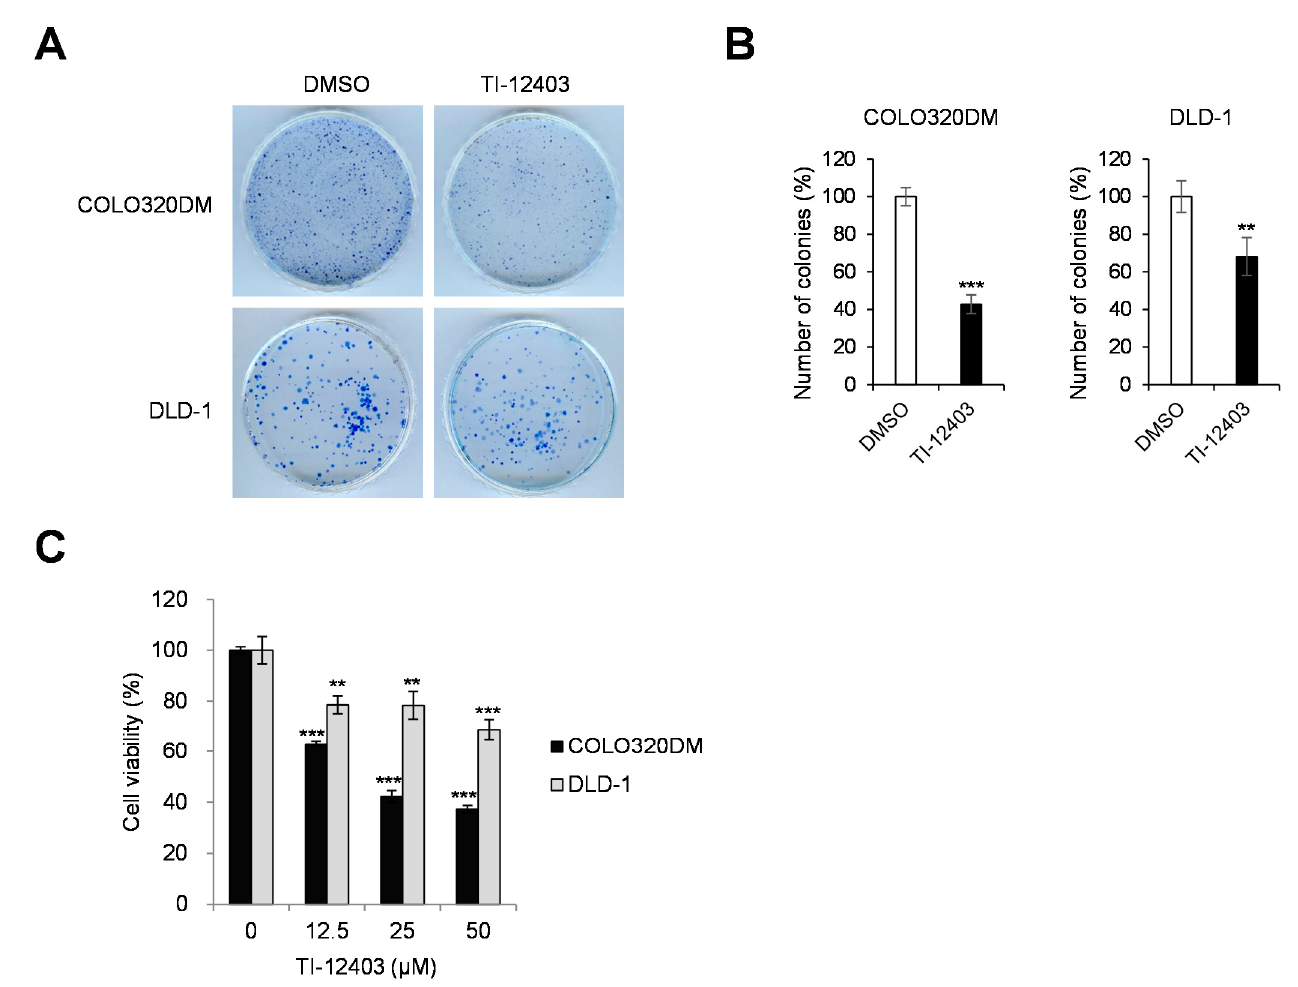
Figure 3. TI-12403 inhibits the growth of adenomatous polyposis coli (APC)-mutated colorectal cancer (CRC) cells. ( A ) COLO320DM and DLD-1 cells were treated with 10 μ M TI-12403 and then incubated for 14 days. Colonies with more than 50 cells were counted. ( B ) Colony formation assay results presented as bar graphs showing the number of colonies. The bar graph represents the normalized values to control group. *** p < 0.001, ** p <0.01 compared to vehicle controls. ( C ) COLO320DM and DLD-1 cells were incubated with TI-12403 at the indicated concentrations. Cell viability was determined by MTT assay 72 h after treatment. ** p < 0.01, *** p < 0.001 compared to respective DMSO-treated cells.